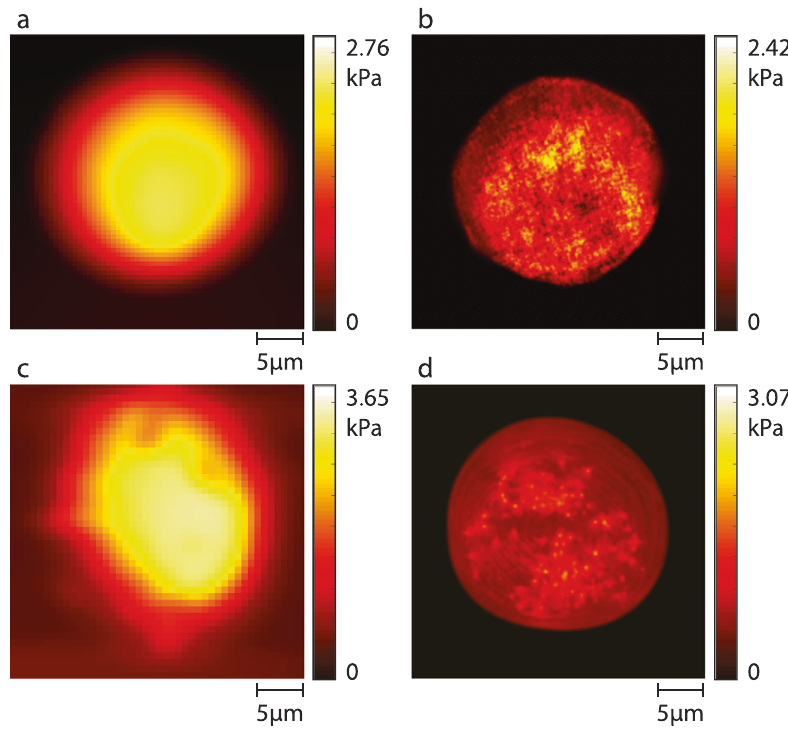
Fig. 2 | Stiffness measurement of microbeads using acousto-holographic ima- ging system and AFM. Stiffness maps of a , b PAA and c , d agarose microbeads obtained from measurement with a , c an AFM, and b , d the proposed acousto- holographicimagingsystem.Averagestiffnessvaluesmeasuredforthemicrobeads shownhereare: a 1.79kPa(PAAmicrobeadswithAFM), b 1.52kPa(PAAmicrobeads